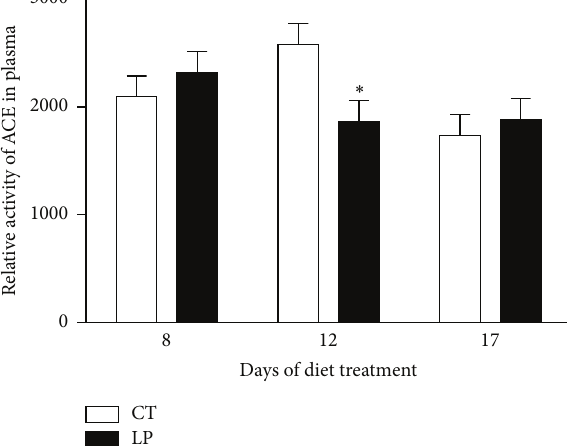
Figure 5: Relative activity of ACE in plasma of nonpregnant rats fed a low-protein diet. CT: control; LP: low protein. The error bar represents the mean ± SEM ( 𝑛 = 6 rats/diet group/day). ∗ 𝑃 < 0.05